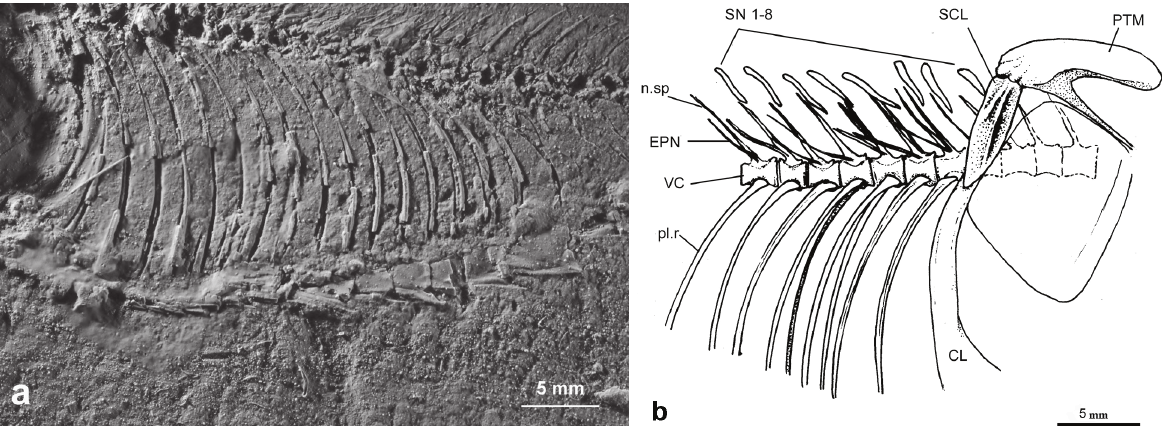
Figure 8. † Scutatuspinosus itapagipensis Santos and Corrêa 1985: ( a ) vertebral column and associated structures of DGM 1164-P; ( b ) pectoral, vertebral column, supraneural bones and associated structures of DGM